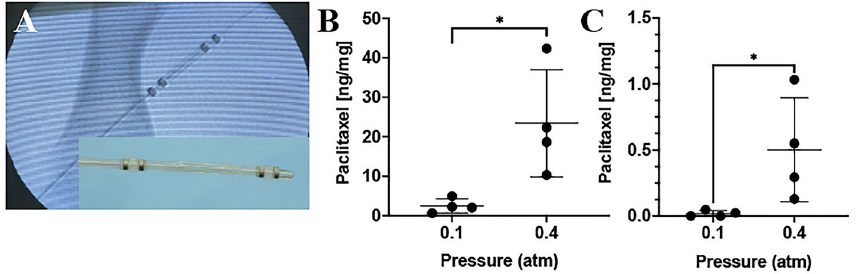
Figure 4. In vivo pharmacokinetic results of varying pressures. ( A ) Angiogram of the perfusion catheter during liquid drug delivery. The liquid paclitaxel is shown filling the treatment chamber (yellow arrows). The occlusion perfusion balloons, which create the treatment chamber, are shown in red arrows. The insert is a picture of the perfusion catheter. ( B ) Arterial paclitaxel retention at 1 h post-delivery for varying treatment chamber (luminal) pressures. ( C ) Arterial paclitaxel retention at 7 days post-delivery for varying treatment chamber (luminal) pressures. *P < 0.05, n =